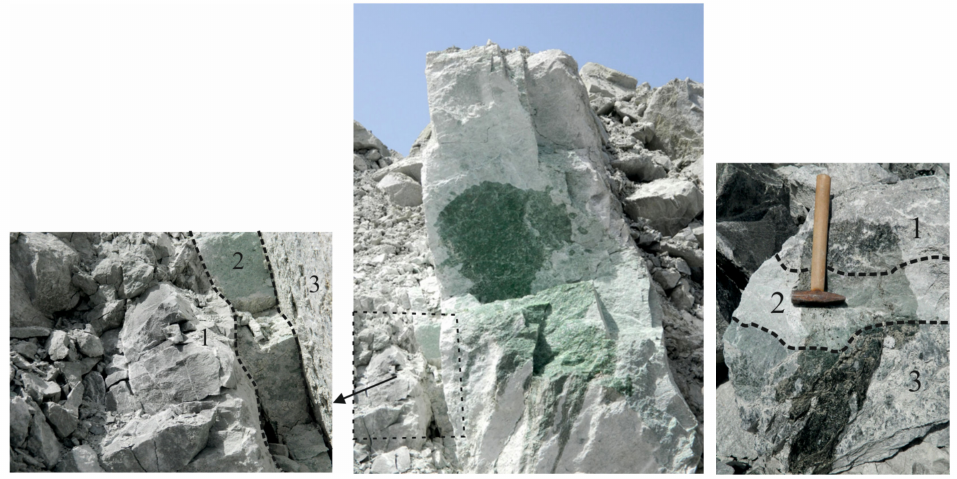
Figure 2. Blocks of nephrite.